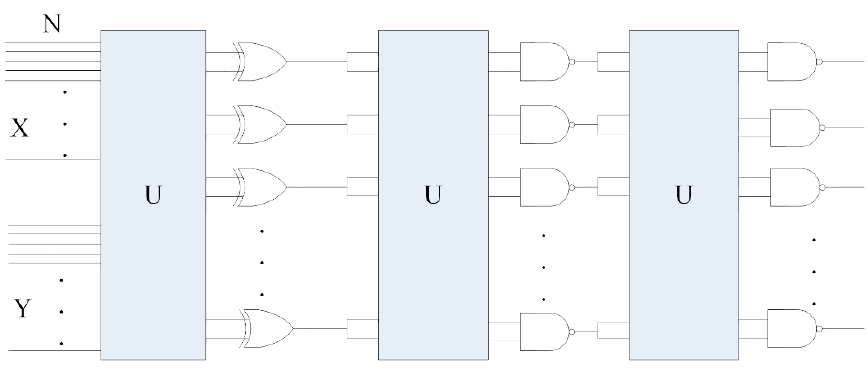
Figure 5. XOR multiplexing system.